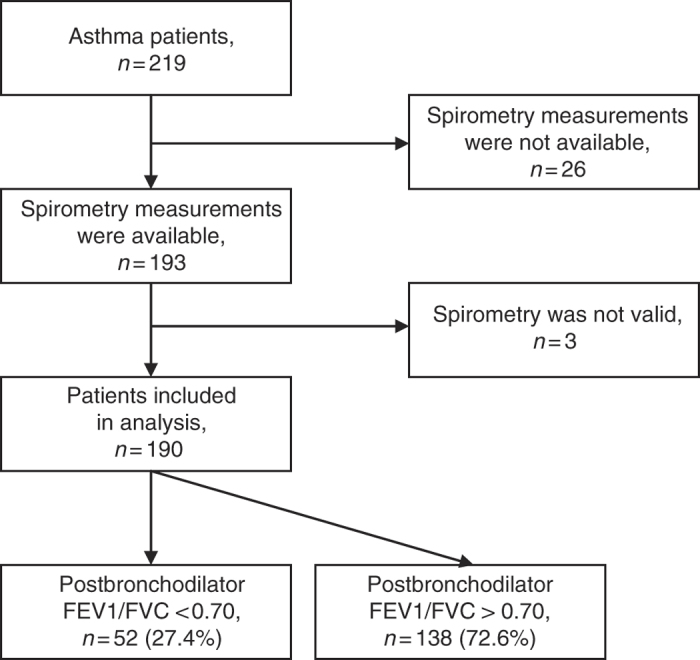
Flow of participants. FEV1, forced expiratory volume in 1 s; FVC, forced vital capacity.